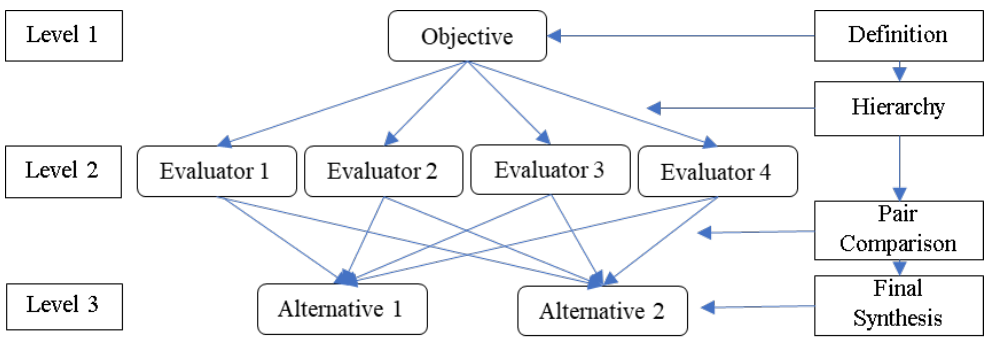
Figure 1. Analytical Hierarchy Structure.